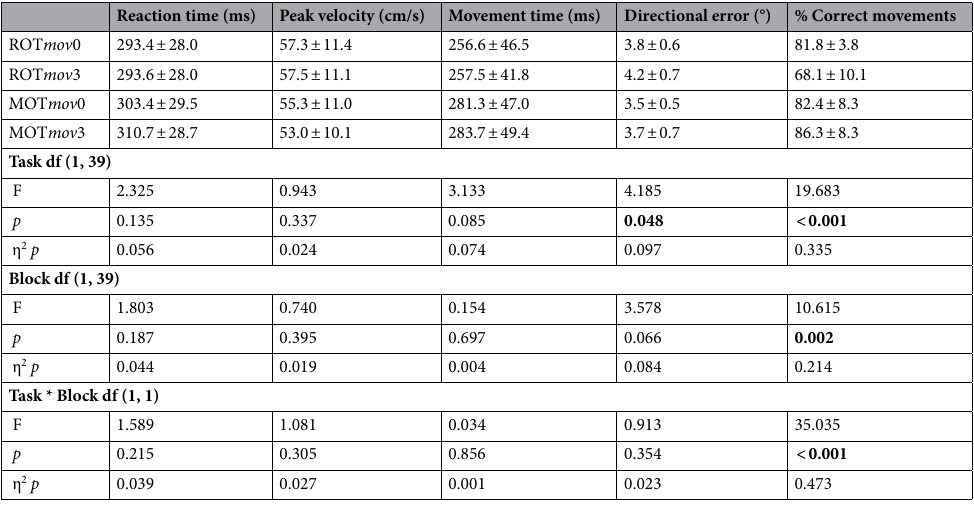
Table 1. mov performance indices. Top: Mean ± standard deviations (SD) for each mov test. Bottom: Results of mixed-model ANOVAs ascertaining the effects of block and preceding task on behavioral indices. Significant differences are reported in bold (p < 0.05). F, test statistics; p, p values; η 2 p, Partial Eta Squared.